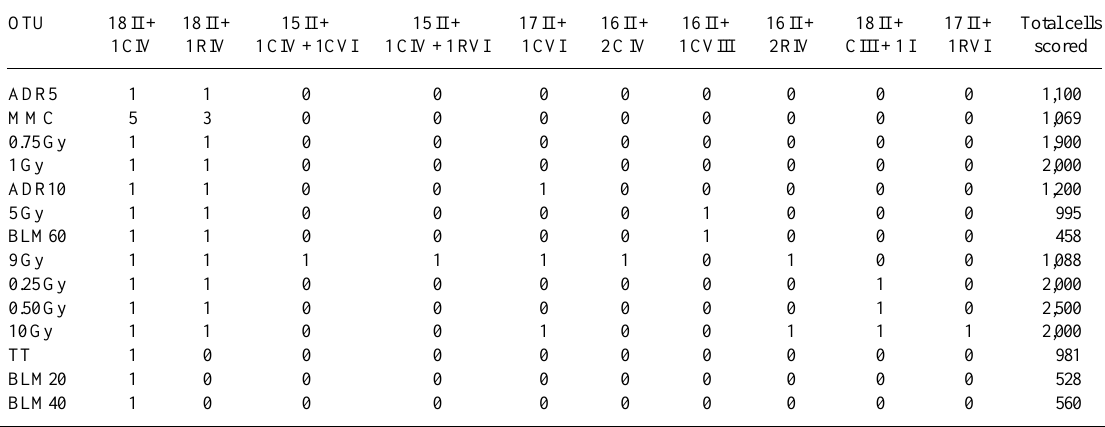
Table IV - Multivalent configurations scored for the different